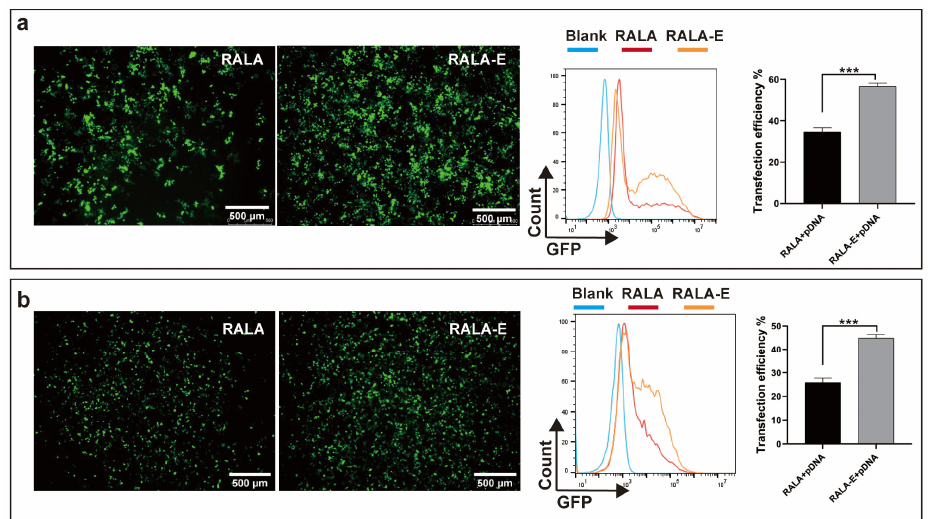
Figure 2. Transfection efficiency of RALA-E/pDNA complexes in 293T and HeLa cell lines. Fluores- cent microscope images, flow cytometry histograms and quantitative results of 293T ( a ) and HeLa ( b ) cell lines, 48 h post transfection with RALA/pDNA and RALA-E/pDNA complexes at N:P ratio of 9 (pDNA concentration: 10 nmol/L). *** p ≤ 0.001.